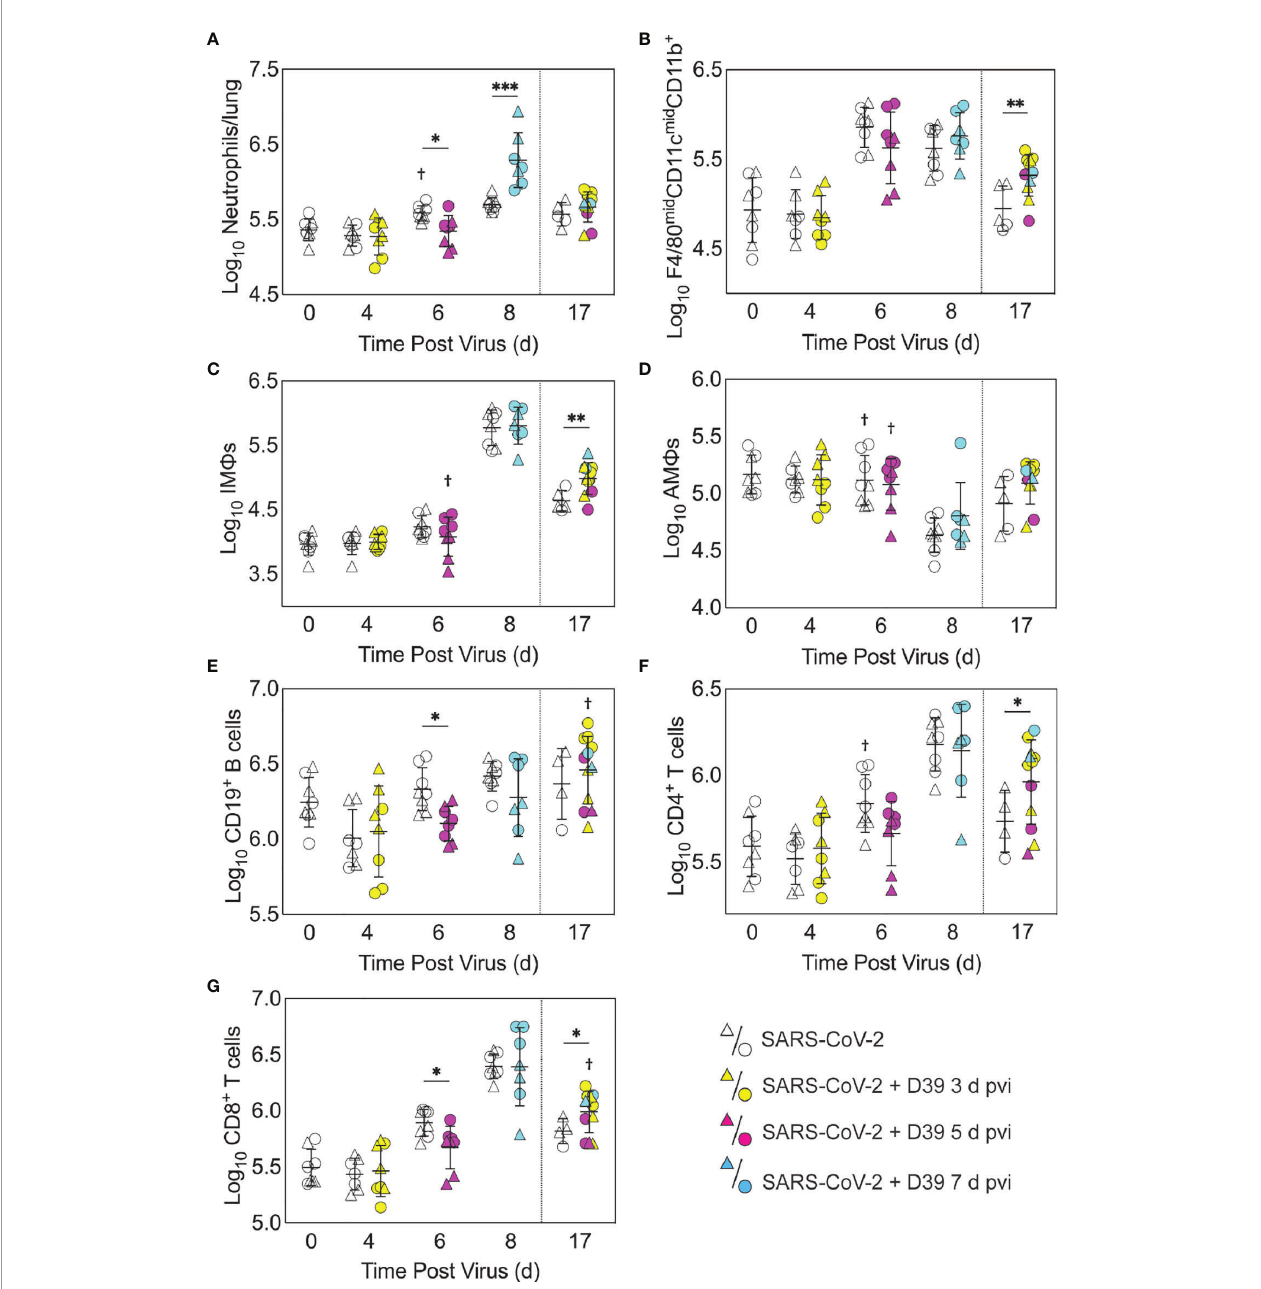
FIGURE 3 | Immune cell dynamics during SARS-CoV-2 infection and pneumococcal coinfection. Total neutrophils (A) , F4/80 mid CD11c mid CD11b + monocytes/ macrophages (B) , in fl ammatory macrophages (iM F ) (F4/80 hi CD11c hi CD11b + ) (C) , alveolar macrophages (AM F ) (F4/80 hi CD11c hi CD11b - MHC-II low/- ) (D) , CD19 + B cells (E) , CD4 + T cells (F) , and CD8 + T cells (G) in the lungs of female (circles) and male (triangles) mice infected with SARS-CoV-2 (250 PFU; open symbols) followed by 10 3 CFU D39 at 3 d (yellow), 5 d (magenta), or 7 d (cyan) pvi. Each symbol represents a single mouse and the mean ± standard deviation (SD) are for combined male and female groups. Signi fi cant differences are indicated by *, P < 0.05; **, P < 0.01; ***, P < 0.001 for comparisons between indicated groups and by † , P < 0.05 for differences between males and females within a group or between coinfection times within 17 d